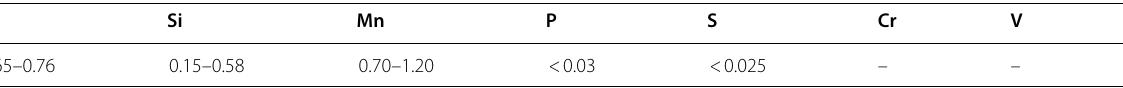
Table 4 Chemical composition of test material